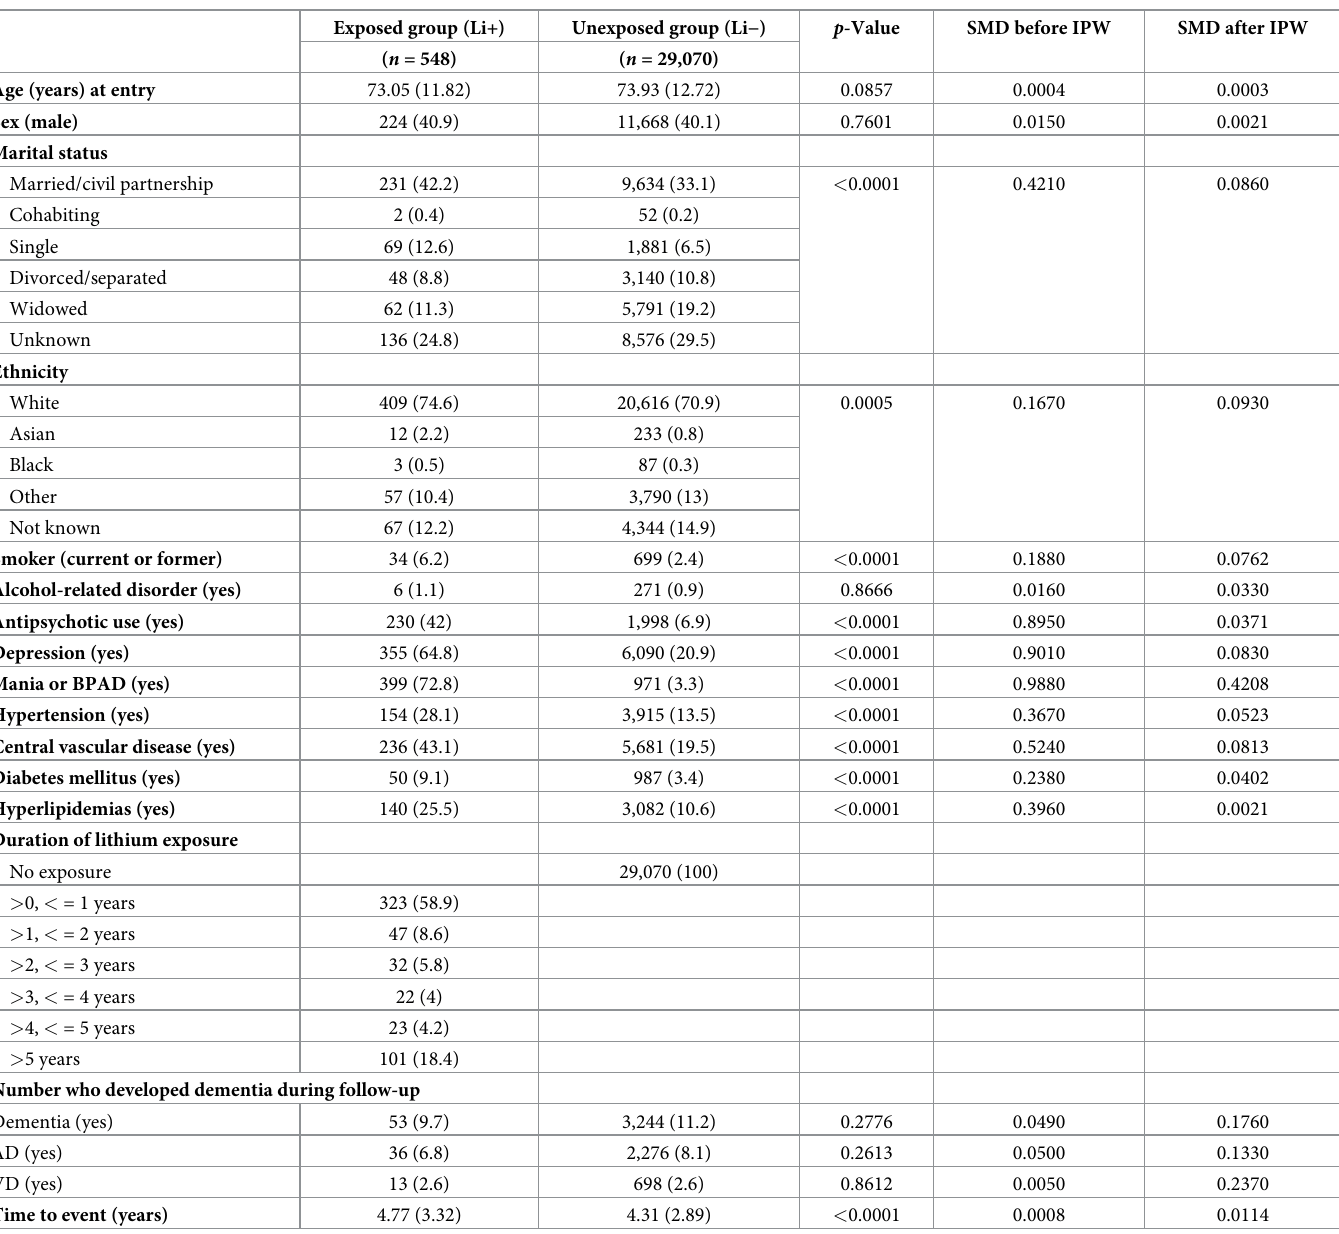
Table 1. Patient